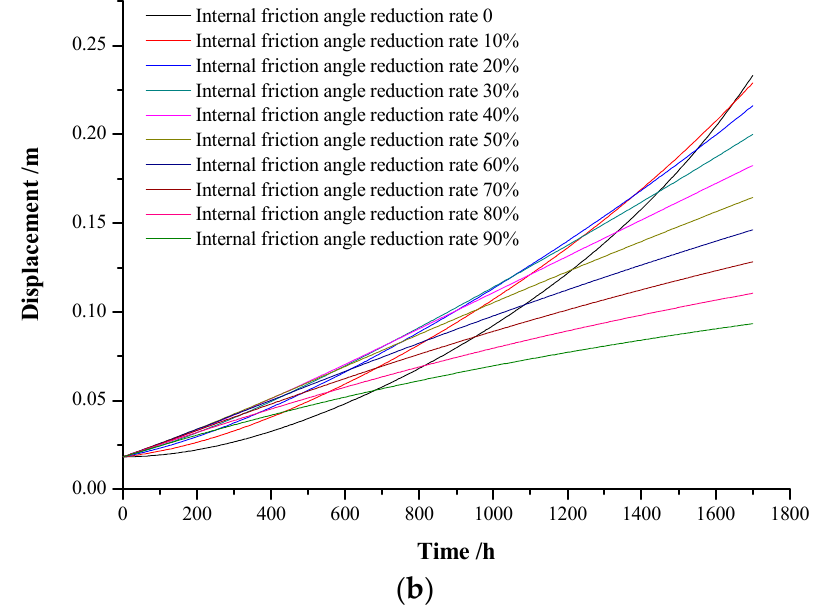
Figure 9. Variation of perimeter displacement with internal friction angle. ( a ) D3 monitoring point. ( b ) D6 monitoring point.